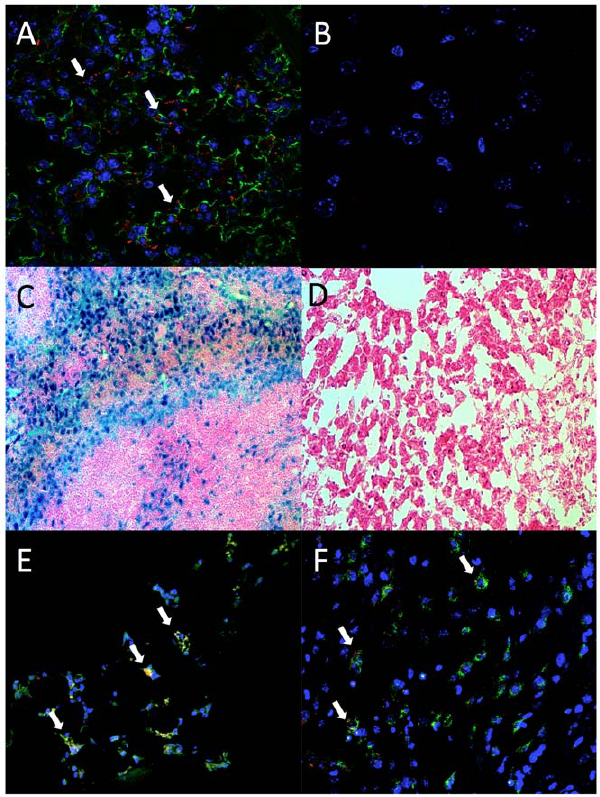
Figure 1. Histological detection of FL-SPION in the liver and spleen 3 days post-injection with FL-SPION, and in FUS-treated muscle 6 days post-injection of FL-SPION and 3 days post-FUS. A Confocal microscopy shows FL-SPION (red) in the spleen are localized with macrophage-specific F4/80 IHC staining (green). B FL-SPION are not as abundant in liver C Prussian Blue staining confirms FL-SPION are predominately taken up in the spleen rather than the liver (D). FL- SPION-labeled macrophages are detected in leg muscle after